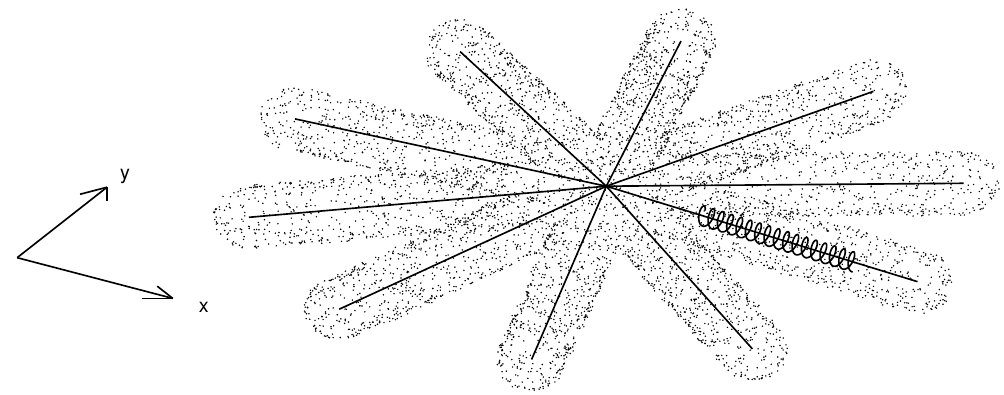
Fig. 5. Schematic description of the starfish-like electrostatic potential structure around positively charged electric sail tethers. An example electron which moves along and spirals around one of the tethers is also